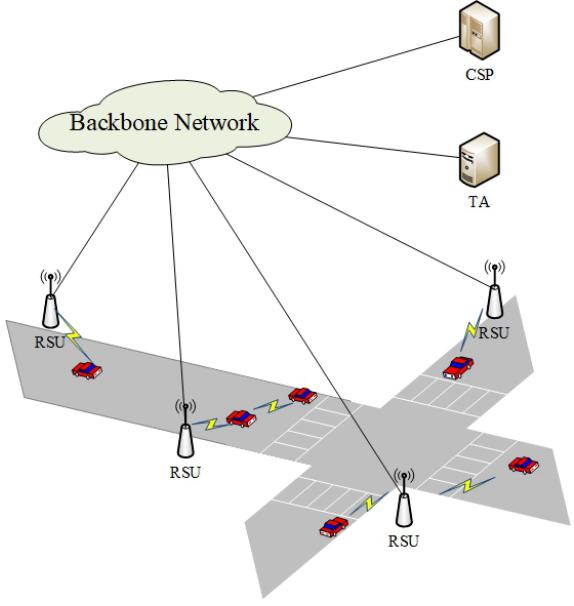
Figure 2. System